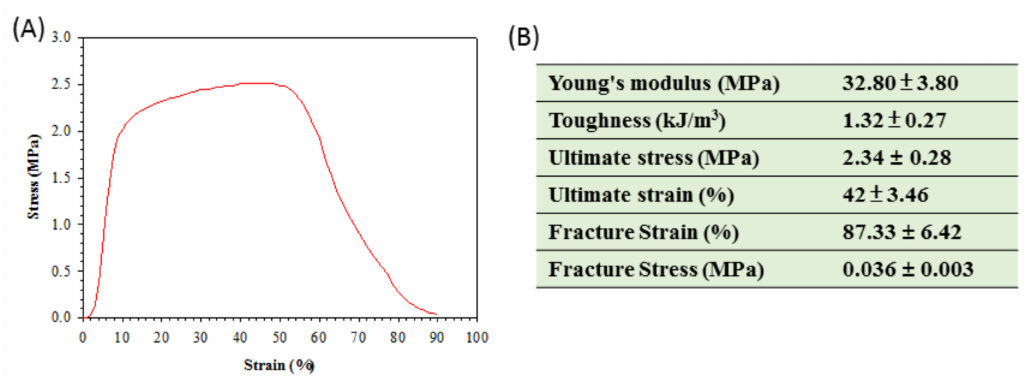
Figure 3. The transmission electron microscope (TEM) ( A ) and the confocal laser scanning microscope (the core solution was labeled with fluorescein isothiocyanate) ( B ) micrographs of polylactic acid / docosahexaenoic acid (PLA / DHA) core-shell nanofibers.